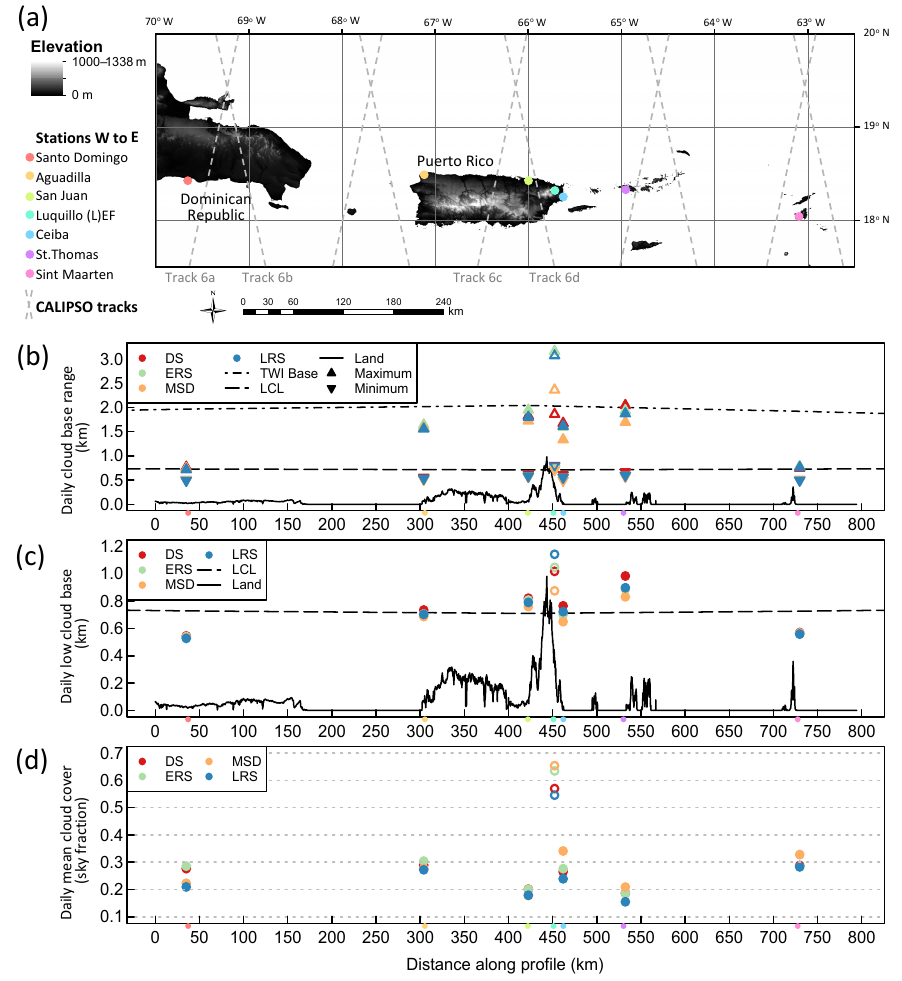
Figure 4. Daily “usual” mean clouds averaged over the winter dry season (DS), early rain season (ERS), midsummer dry season (MSD), and late rain season (LRS) for the period of record (POR) across the region: (a) locations of airport (ASOS) stations, Luquillo Experimental Forest (LEF) station, and CALIPSO satellite tracks, along with topography; (b) daily minimum and maximum cloud bases (of hourly means), splined lines of trade-wind inversion (TWI) base and lifting condensation level (LCL) based on three geographical calculations, and land surface elevation along profile; (c) daily low cloud base (first quartile, Q 1 , of hourly means), estimated LCL, and land surface elevation along profile; (d) daily mean cloud cover as fraction of sky. The land surface profile trends due east and west (shifting north and south to be near the stations). Station locations are marked with circles on the x axis in the same colors as (a) . Dashed colored lines between San Juan and Ceiba are used to indicate that the LEF station measurements are only based on the available LEF POR, May 2013–August 2016, excluding non-representative months for all of 2000–2016. “Usual” is defined as hours with cloud cover at least 50% of mean-POR cloud cover for